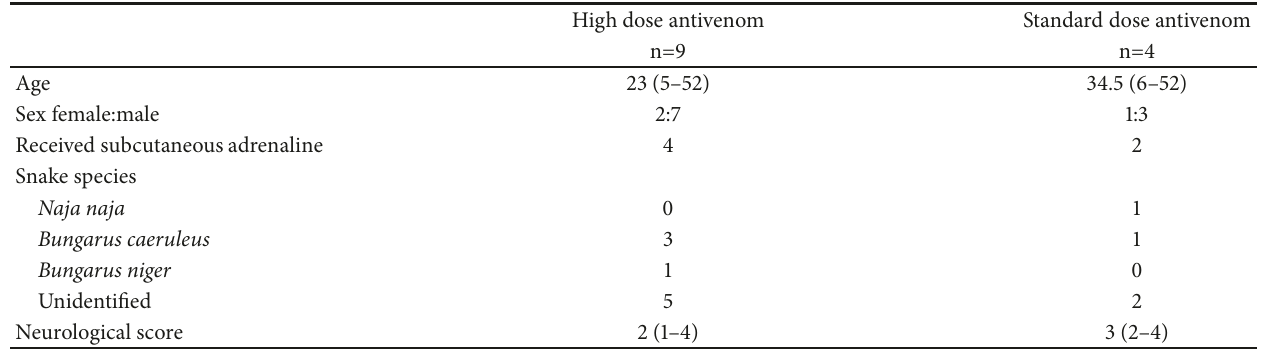
Table 1: Baseline characteristics of the 13 patients by dose of